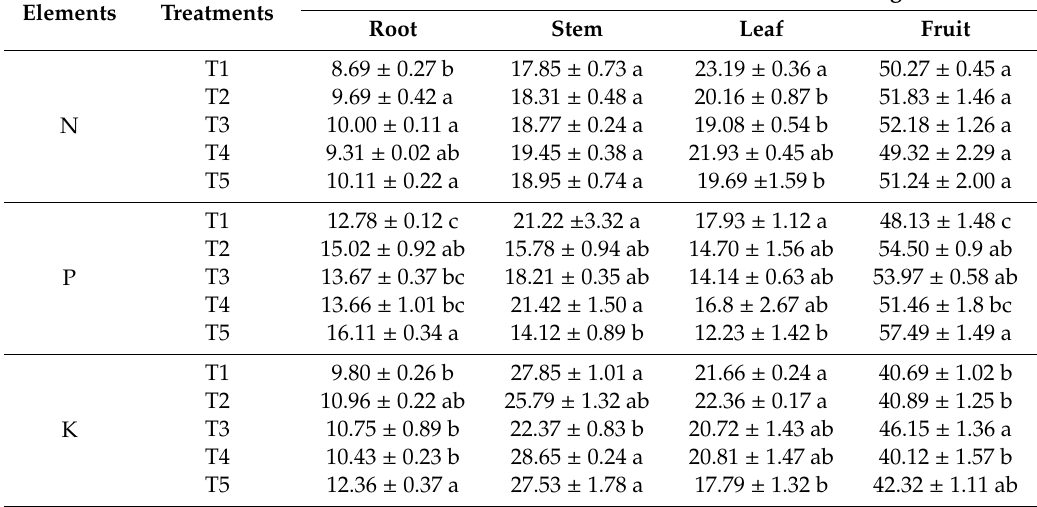
Table 5. E ff ects of NH 4 + :NO 3 − ratios on N, P and K distribution in the di ff erent pepper organs 120 d after